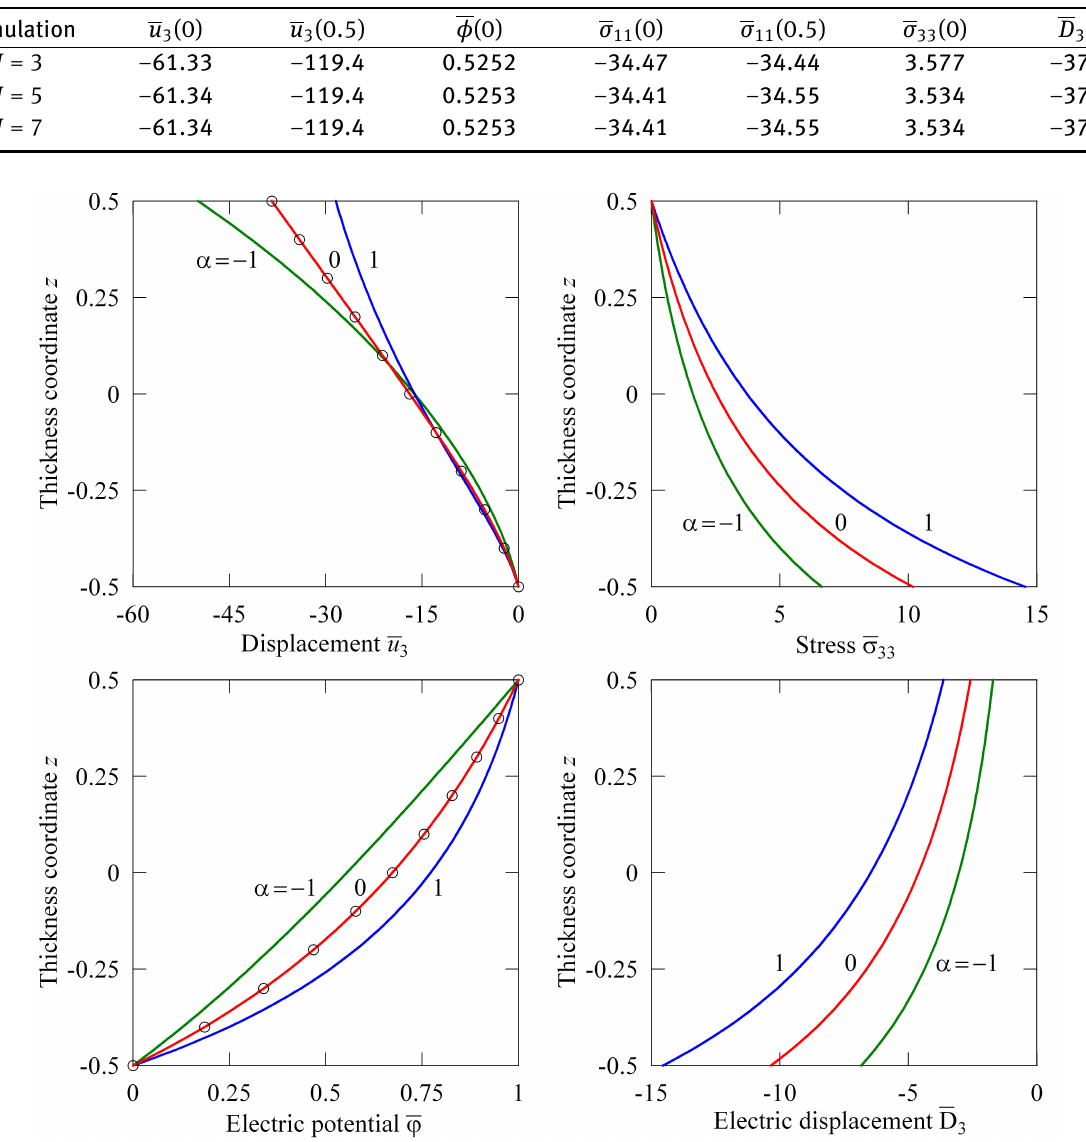
Table 5: Results for a FGM piezoelectric sphere with R / h = 10 and α = 0 using 64 × 1 mesh. Formulation